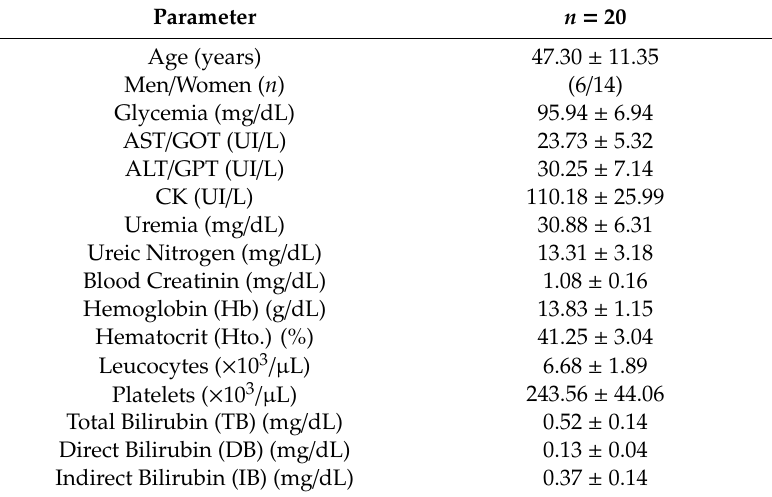
Table 1. Basal clinical and demographic characteristics of the study group.